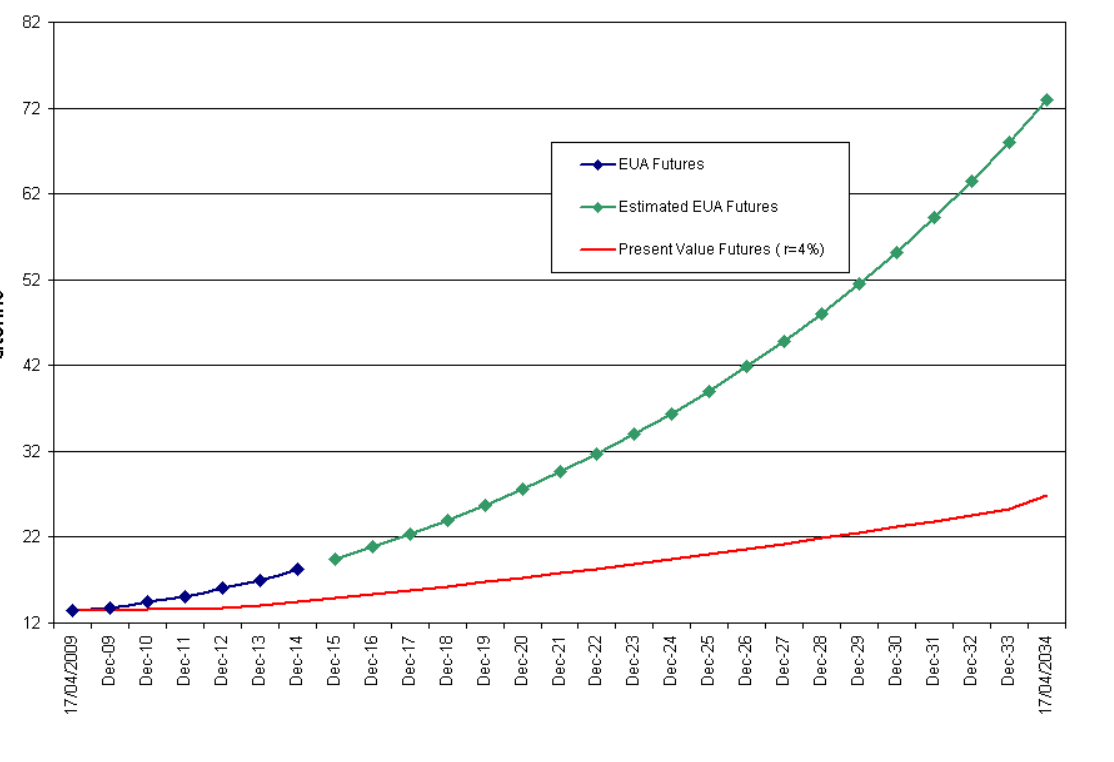
Figure 7. Futures prices of European Union emission allowances (blue line), estimated prices for the distant future (green line), and futures prices discounted to the present (red line). Source of EUA prices: